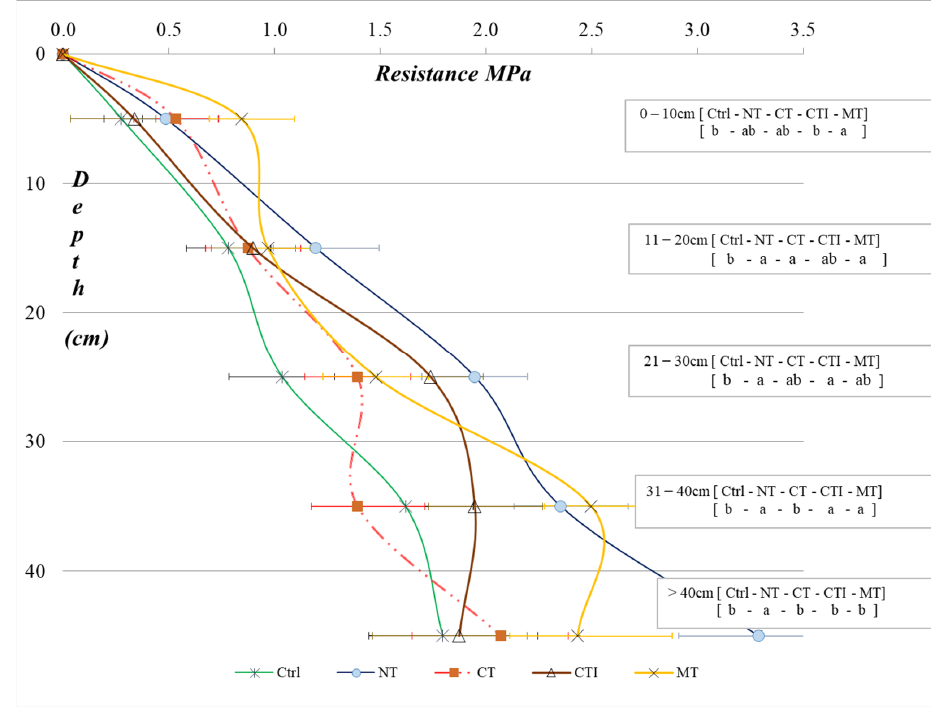
Figure 2. SPR in rows at different soil depths; control (Ctrl); no ‐ tillage (NT); minimum tillage (MT); conventional preparation (CT) and conventional preparation I (CTI). In the boxes next to the graph, means followed by the same letter for each depth interval do not differ by Tukey’s test, at 5% sig ‐ nificance.